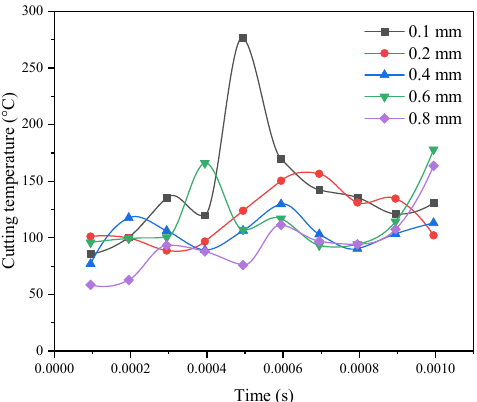
Figure 6. Comparison curve of the cutting temperature with different corner radii.